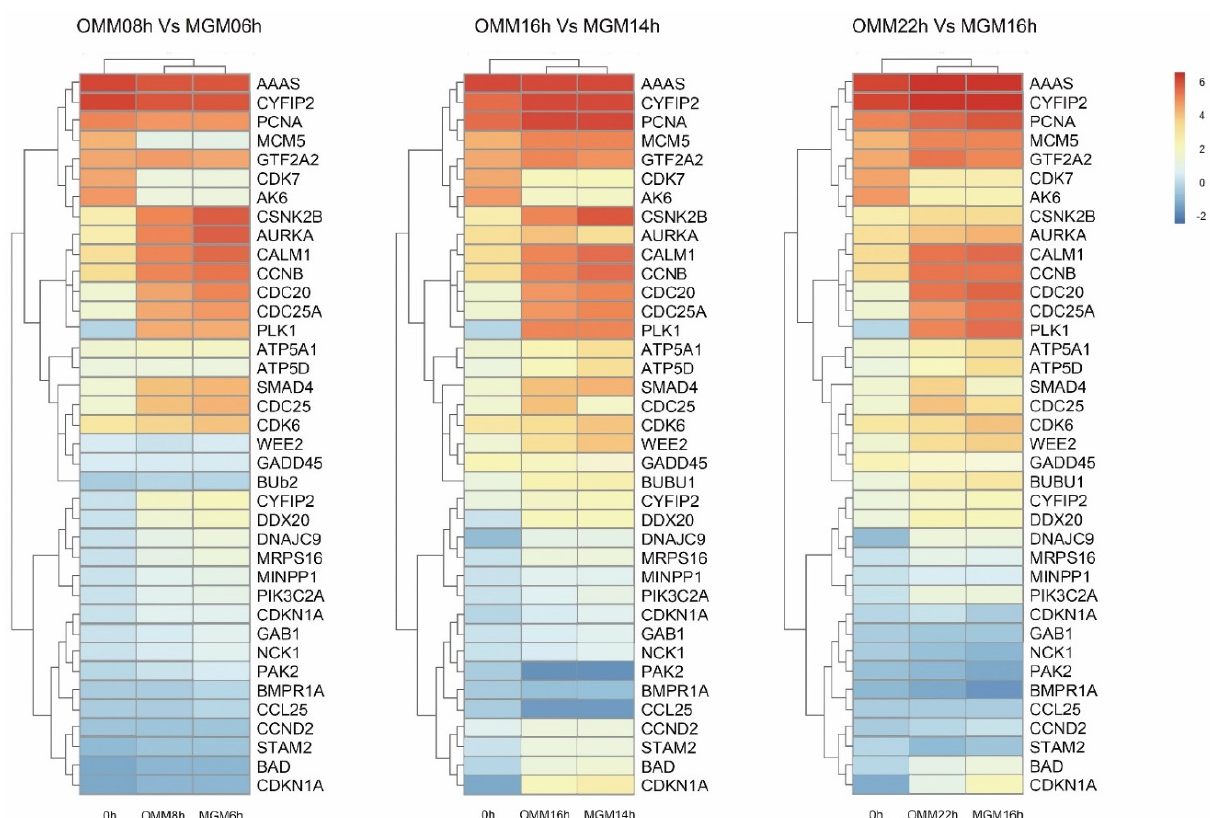
Figure 5. Heatmap showing the expression comparison of markers at different time points. Ribosome synthesis, generation of oxidative phosphorylation, cell cycle, RNA transport, metabolism of inositol phosphate, meiosis of oocytes, PI3K-AKT signaling pathway, and other differentially significant genes.